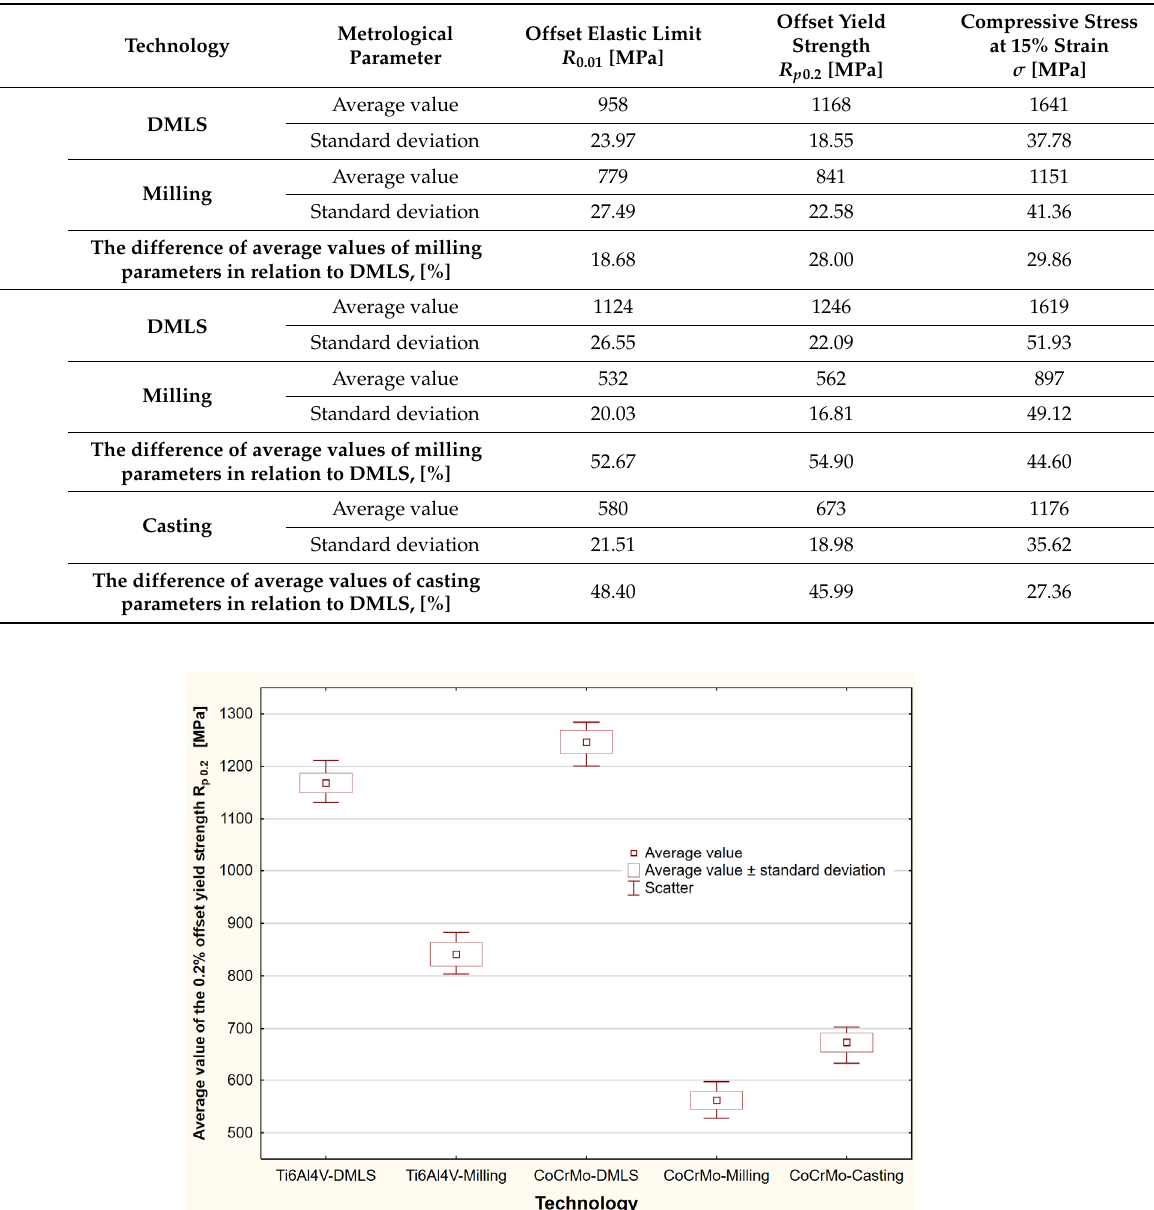
Table 2. List of strength parameters of the tested biomaterials, depending on the manufacturing technology, in axial compression tests.